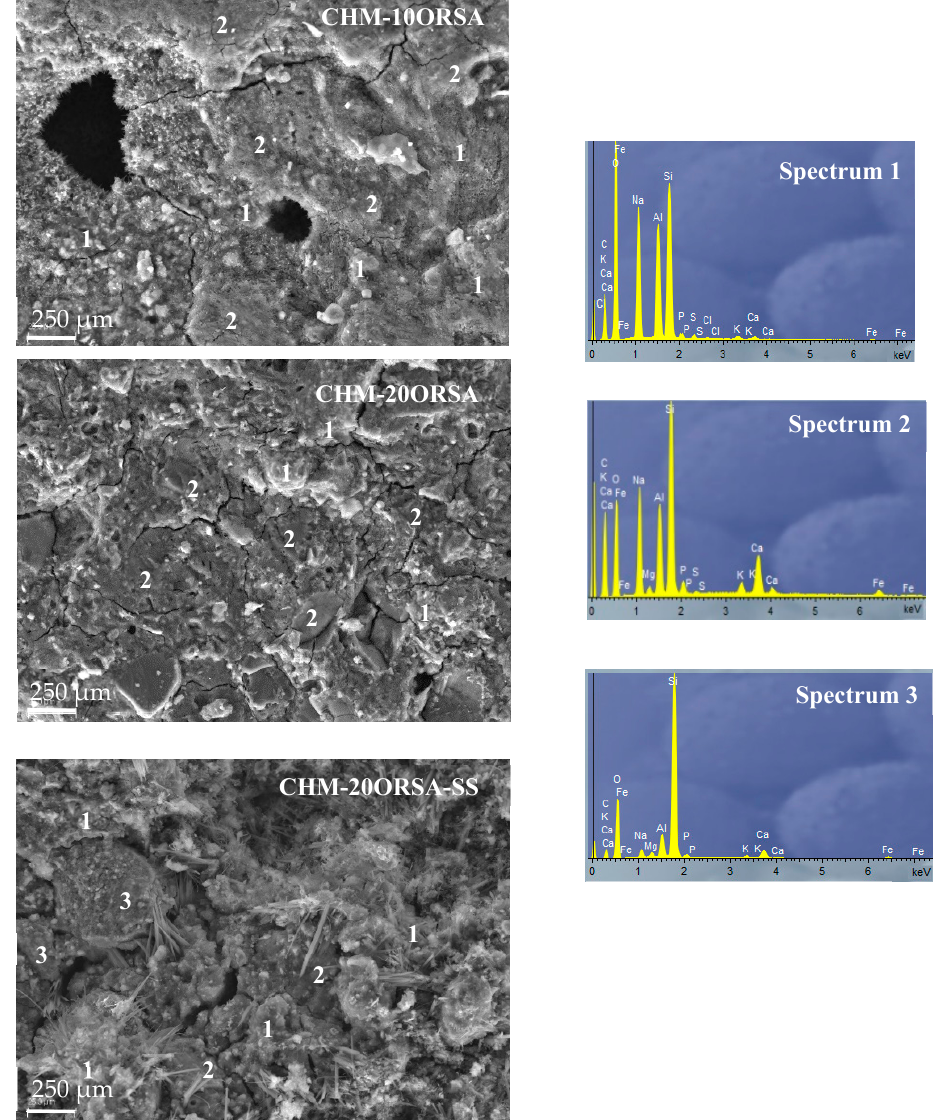
Figure 10. SEM micrographs-EDX analysis of CHM-10ORSA, CHM-20ORSA and CHM-20ORSA-SS .